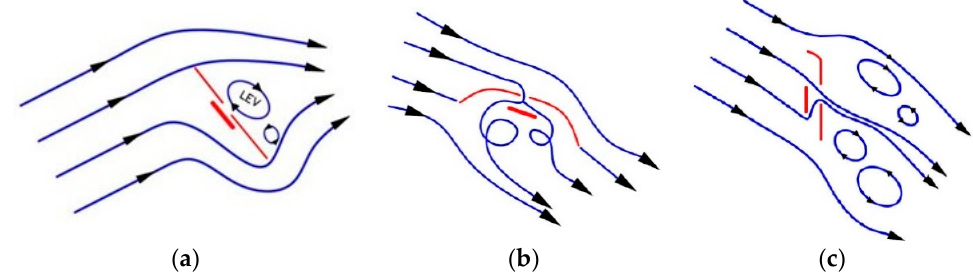
Figure 11. Concept design about the airflows on flapping wing surfaces with check valves: ( a ) air flow on the wing membrane with check-valve closing during downstroke, generating apparent positive lift; ( b ) flow separation due to check- valve opening during upstroke of an inclined wing, producing less negative lift; ( c ) flow separation due to check-valve opening during upstroke of a vertical wing, producing less positive lift.